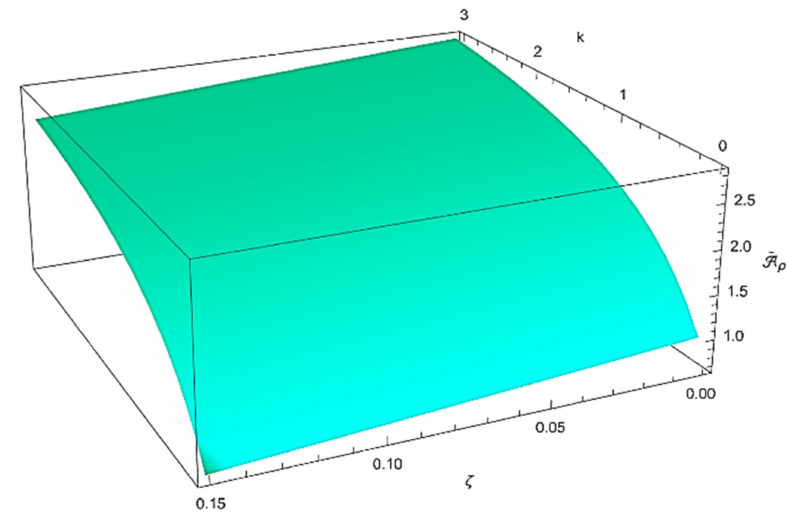
Figure 4. Combined effect of the gradient index ( k ) and the porosity volume fraction ( ζ ) on the dimensionless effective cross-sectional mass A ρ .